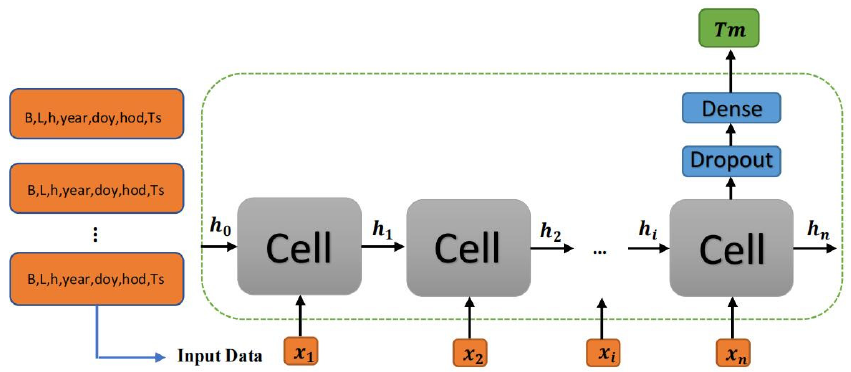
Figure 4. The structure of RNN and LSTM models.